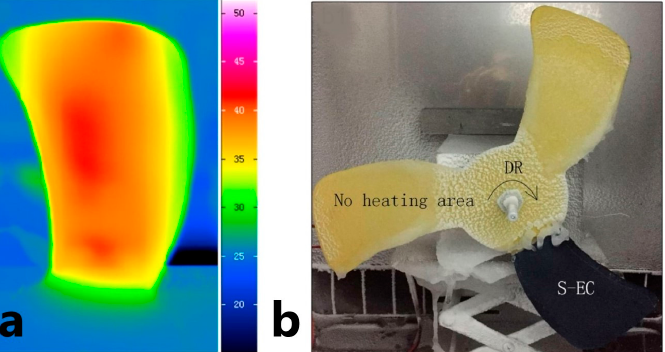
Figure 13. The application of the coating on rotating blade surface. ( a ) Infrared image of the blade coated with an electric heating coating (S-EC) supplied by direct current voltage. ( b ) The images after anti-icing test; DR represents the direction of rotation (Reprinted with permission from Elsevier, copyright 2018) [158].